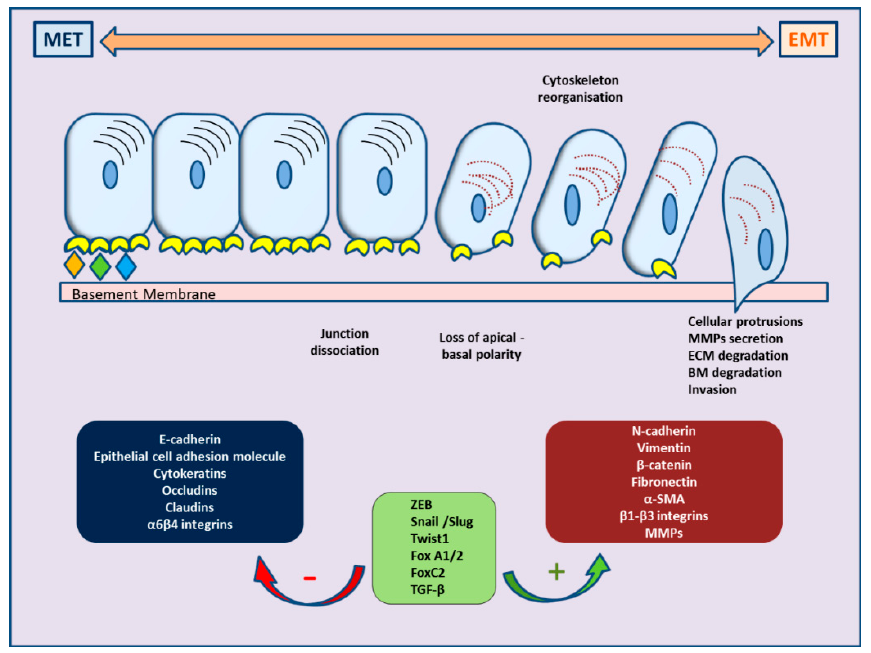
Figure 1. Schematic representation of cellular changes and main molecular events during epithelial– mesenchymal transition (EMT) and the reverse MET.